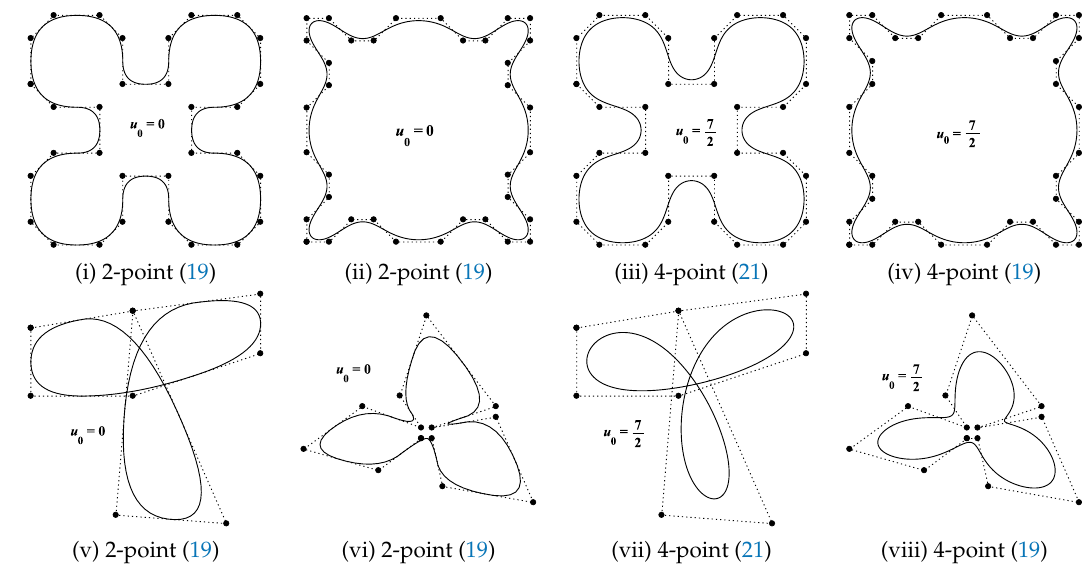
Figure 1. Four subdivision levels of SSs (19) and (21) have been used to the control polygon when control points are moved over a short distance,